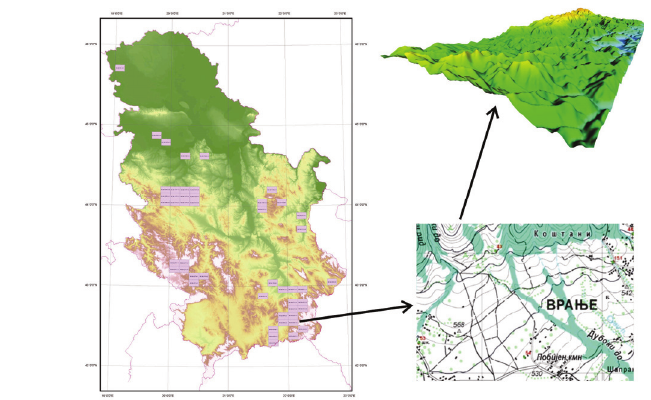
Figure 2 – Test area for positional accuracy